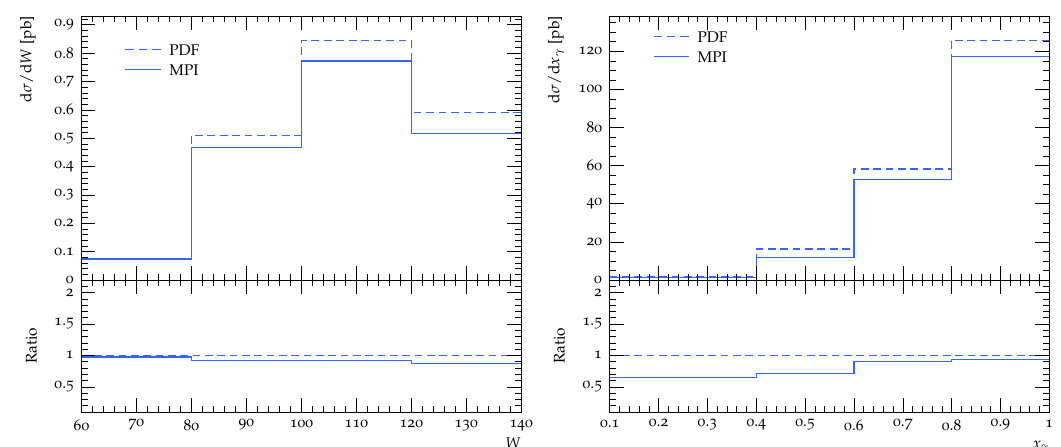
Figure 3: The differential cross sections in terms of W (left) and x obs sponding to EIC kinematics at MPI